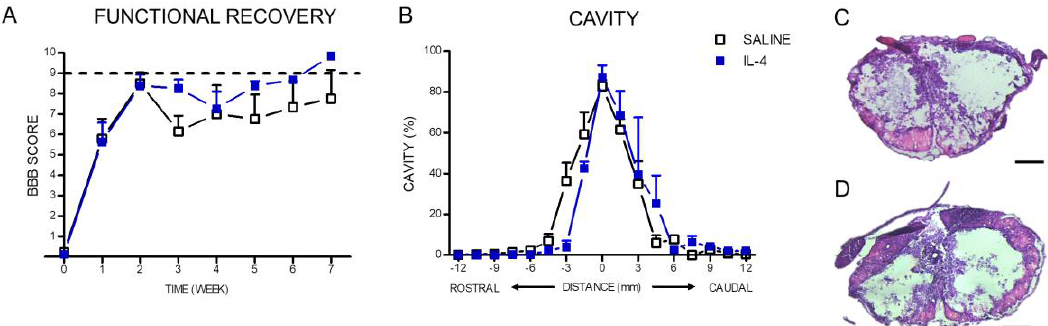
Figure 9. Despite the fact that no statistical differences were found between the Basso, Beattie and Bresnahan (BBB) score of each group, all IL-4 treated rats recovered weight support at week 7 post injury contrasting with only 33% of the saline group ( A ); Hematoxylin-staining revealed no differences on the lesion area extent ( B ); Representative images of hematoxylin–eosin staining of saline ( C ) and IL-4 treated ( D ) group. Values shown as mean ± SEM. Scale bar = 400 µm.